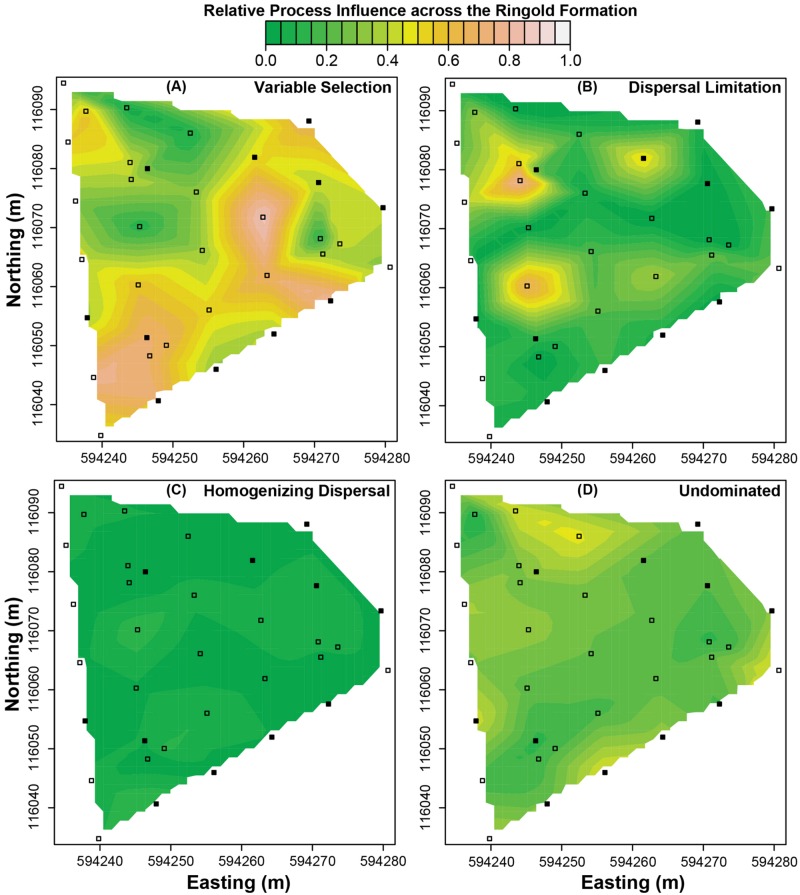
Predicted spatial variation in the relative influences of ecological processes across the Ringold formation. (A) Variable selection, (B) dispersal limitation, (C) homogenizing dispersal, and (D) the undominated fraction. Squares indicate spatial locations where field samples were used to estimate environmental features. Filled squares indicate where field samples were also used to characterize microbial communities. The scale bar applies to all panels.